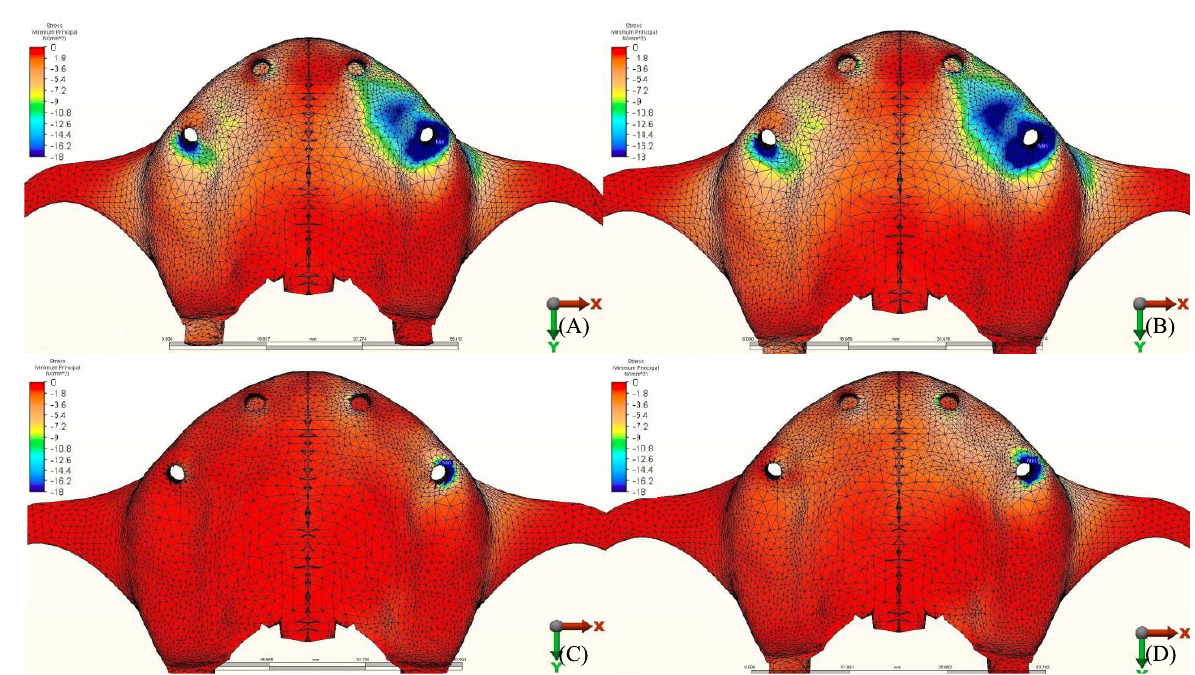
Figure 11. Pmin stress distribution in cortical bone for group 3, PEEK bar with composite resin gingiva and ceramic superstructure with zirconium (Toronto bridge). ( A ) Model 3.1, opposing natural tooth. ( B ) Model 3.2, opposing tooth-supported full ceramic crown. ( C ) Model 3.3, opposing acrylic prosthesis with titanium framework. ( D ) Model 3.4, opposing implant-supported full ceramic crown .